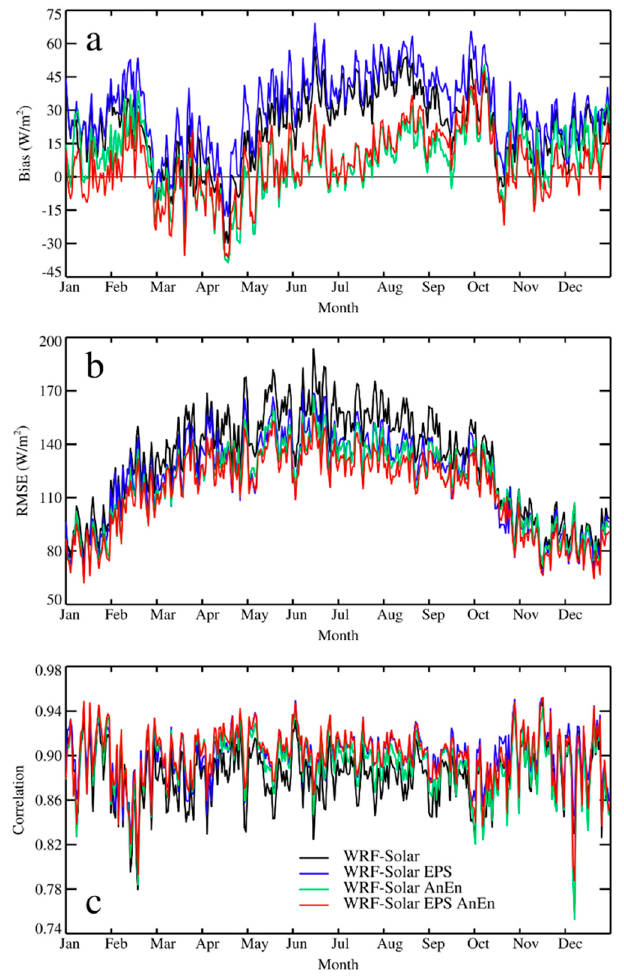
Figure 5. Bias, RMSE, and correlations were computed for GHI for each day of the year 2018 for the forecast lead times from +24 to +48 h by pooling all the grid points together.